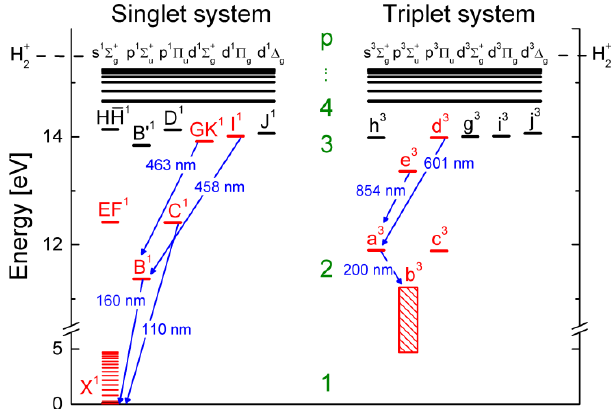
Figure 6. Energy-level diagram of the hydrogen molecule.